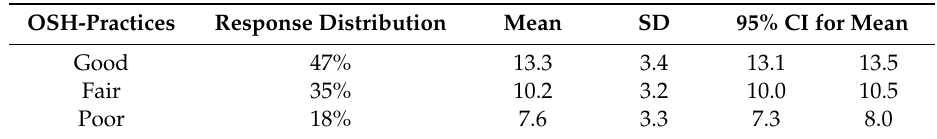
Table A5. Distribution of responses, mean, standard deviation (SD), and 95% confidence interval (CI) for mean of PSC-4 (range 4–20) depending on OSH practices, based on a random sample of non-managerial employees from the Swedish working population ( n = 1882).